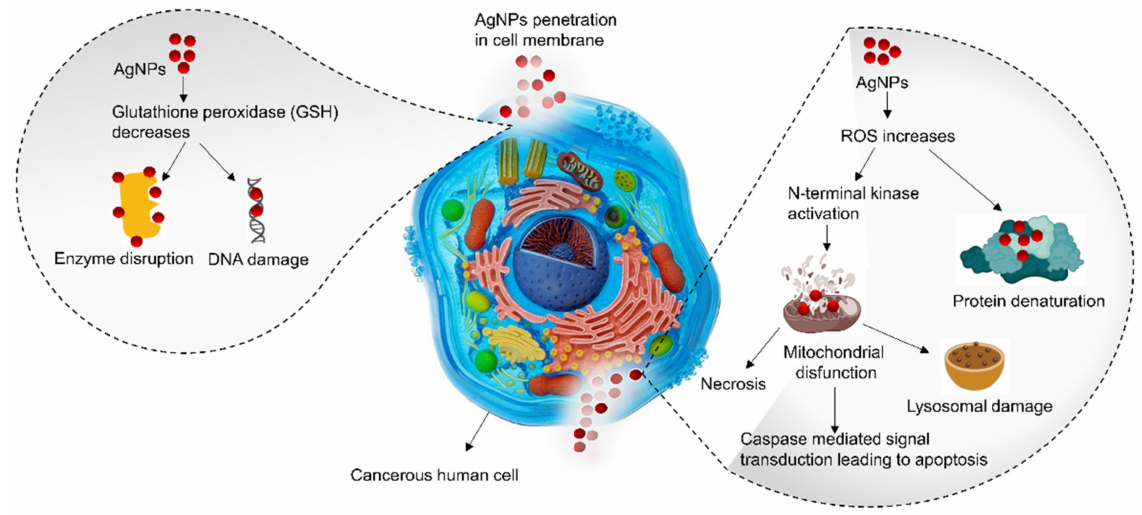
Figure 4. Illustration of the proposed mechanism for anticancer activity of